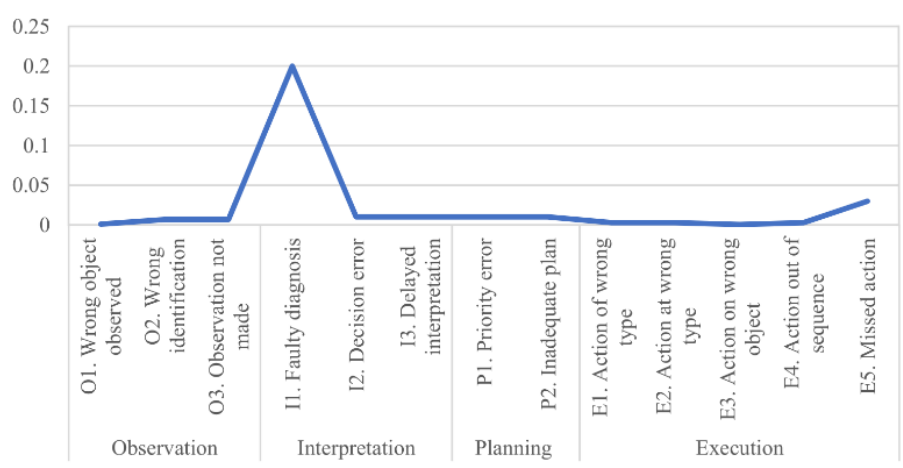
Figure 4. Basic values and uncertainty bounds for cognitive function failures.